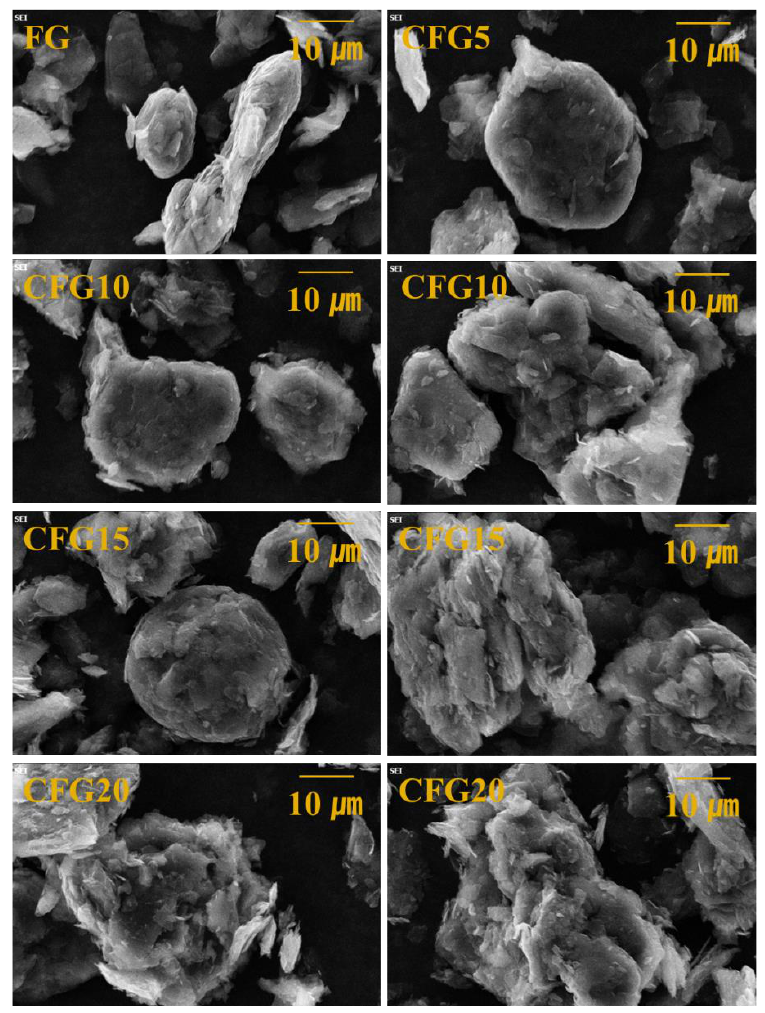
Figure 1. SEM images of FG, CFG5, CFG10, CFG15, and CFG20. Table 1. Particle size distribution and surface area to investigate particle aggregation.